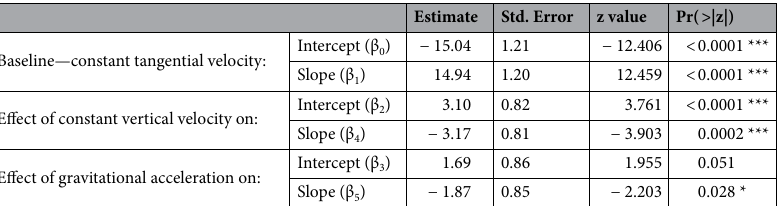
Estimate Std. Error z value Pr(